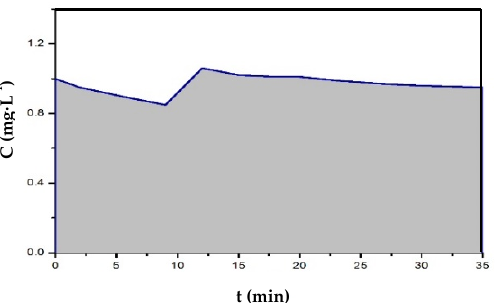
Figure 1. Principle schematic diagram of the integration calculation for Ct values.